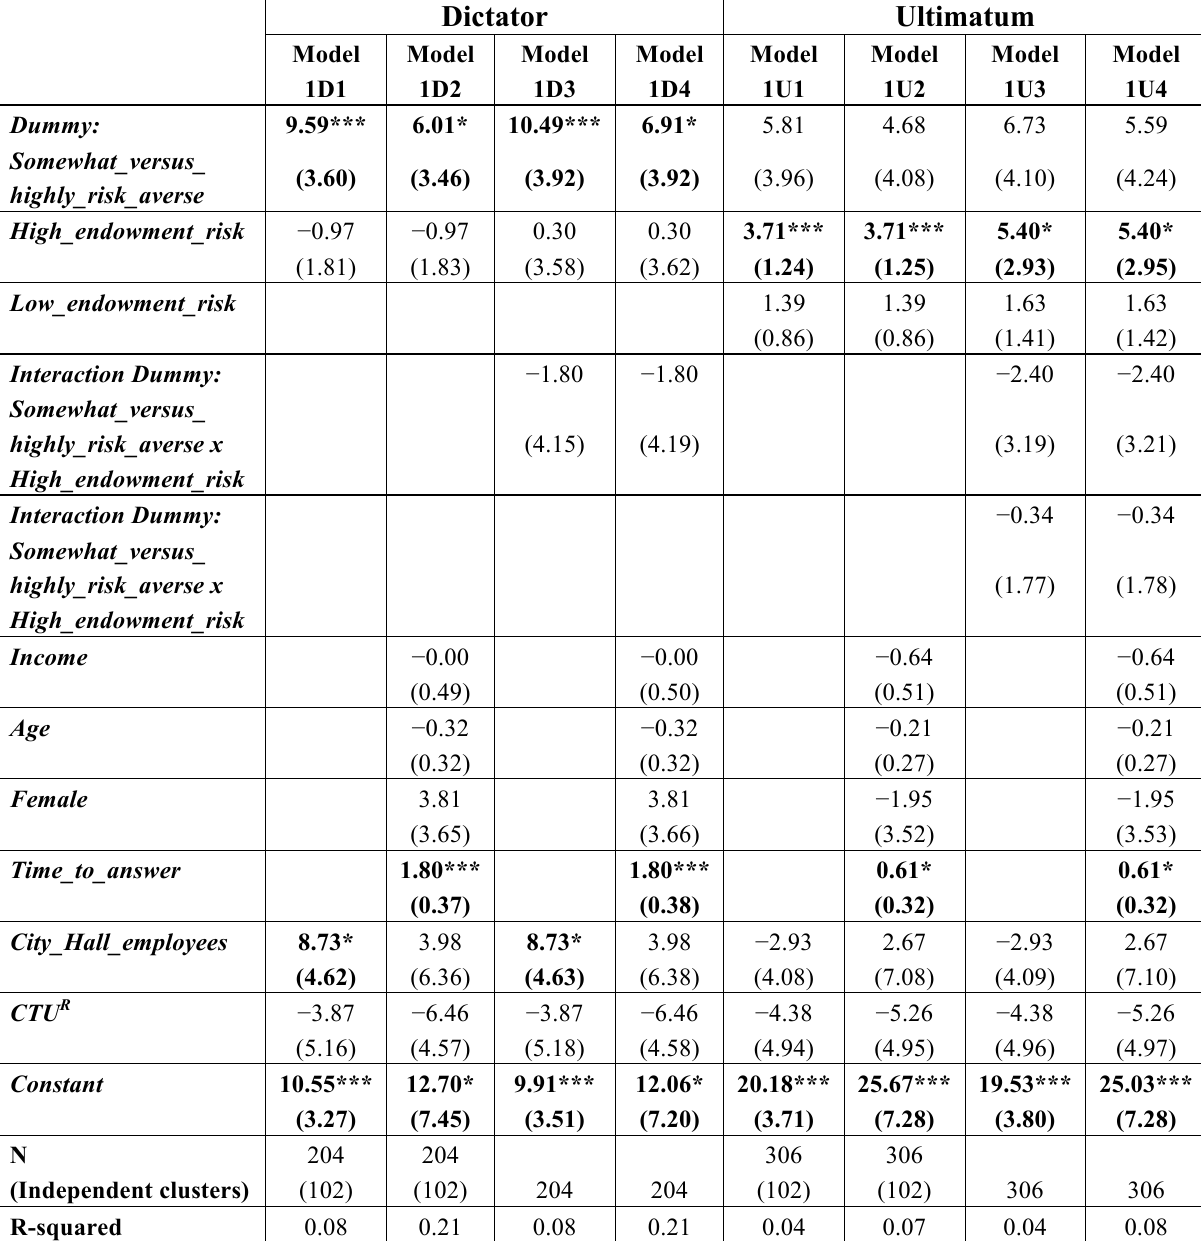
Table 6. Linear regression of giving on risk aversion and risk in the Dictator and Ultimatum games (with clustered